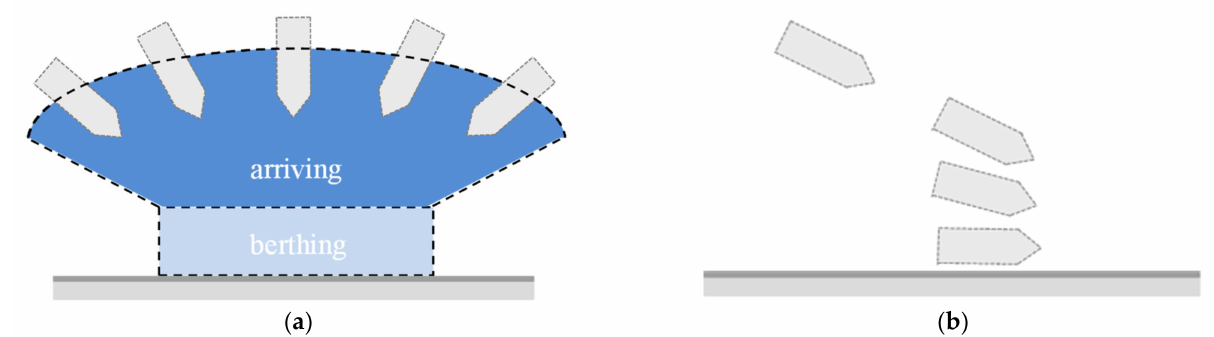
Figure 8. Schematic diagram of the ship berthing process: ( a ) arriving and ( b ) berthing.